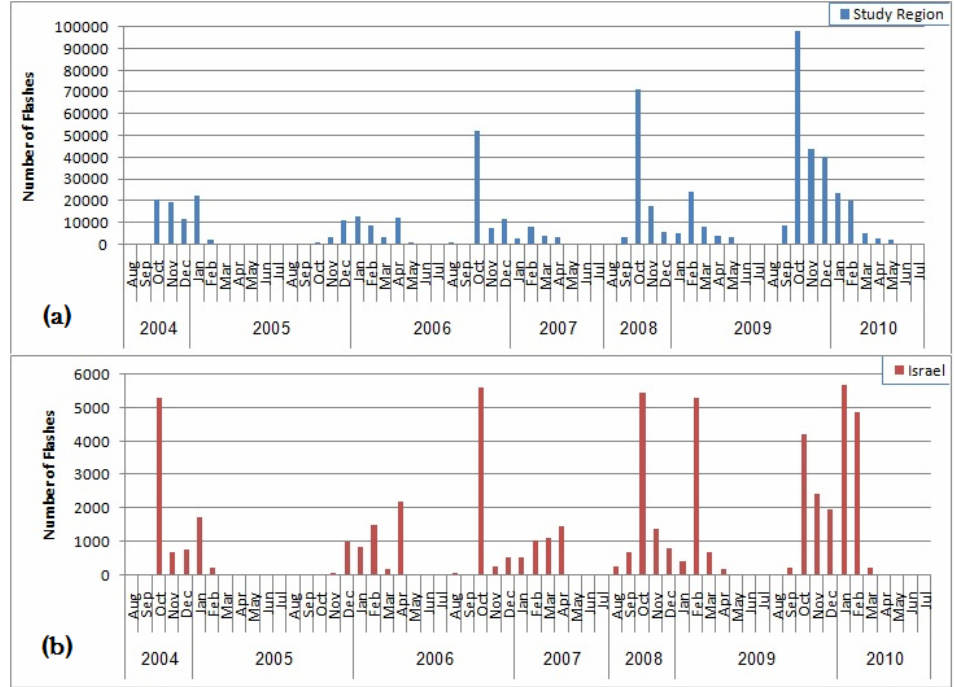
Fig. 4. The number of flashes per month for the study region (a) and for Israel (b)